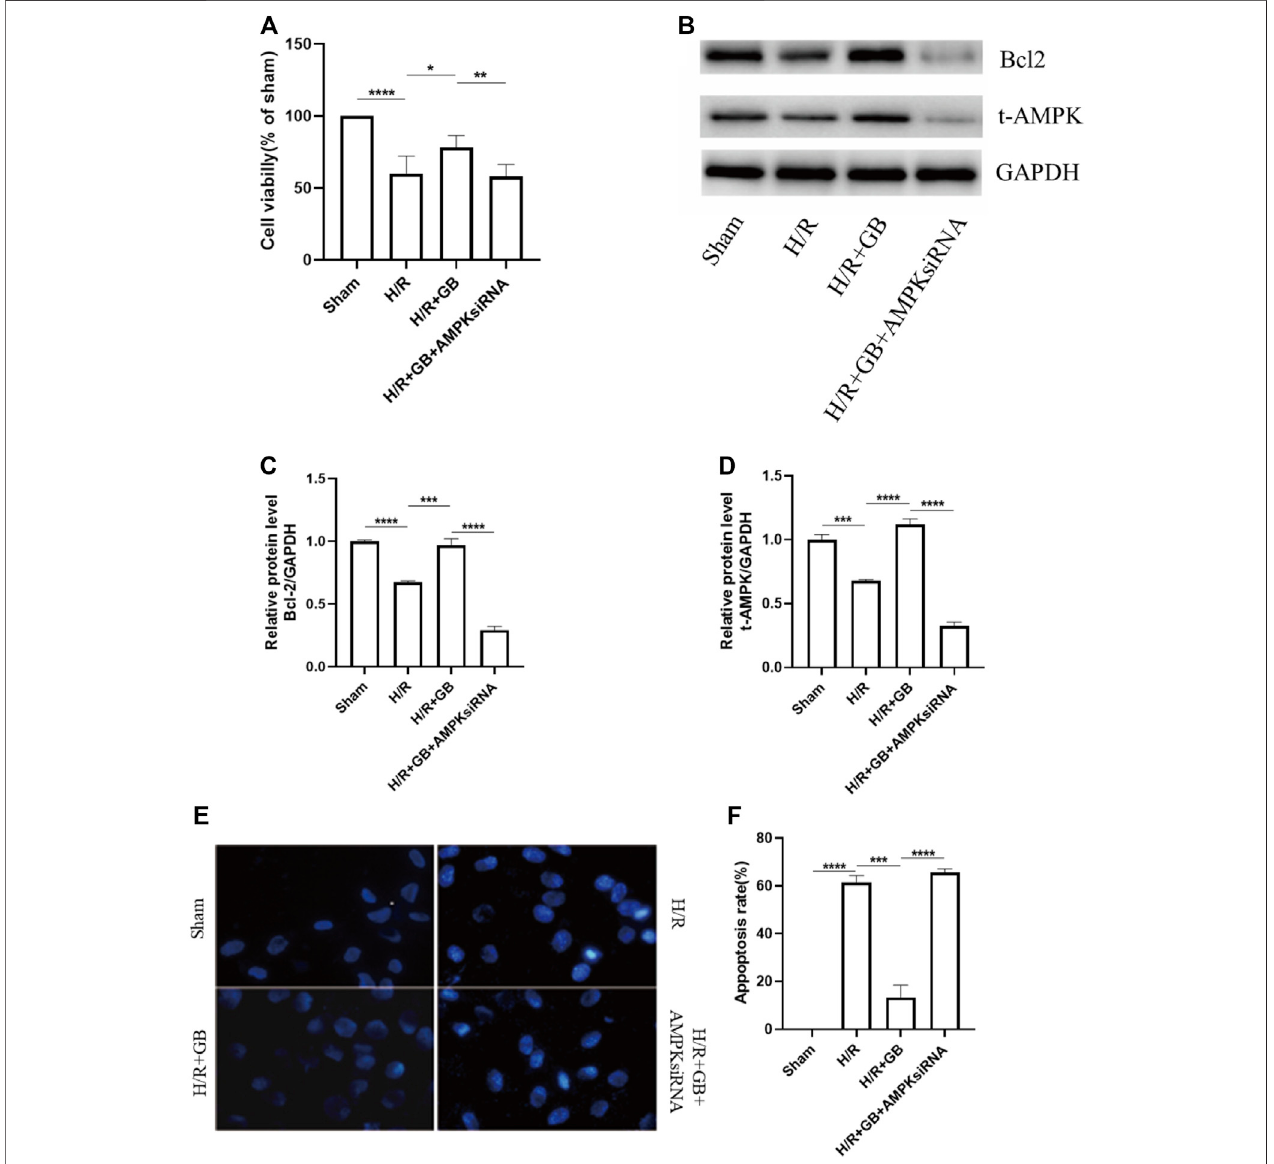
FIGURE 2 | (A) MTT assay was utilized to evaluate cell viability. Data are expressed as mean ± SEM and are representative of 3 separate experimentations. (B – D) Western blot images of Bcl-2, AMPK in SH-SY5Y cells subjected to H/R and treated with or without GB. (E,F) Hoechst 33342 staining representative images (E) . Bar graphs illustrating the apoptosis rate of the cells subjected to various treatments (F) . Data are expressed as mean ± SEM and represent 3 distinct experiments. (*** p < 0.001, **** p < 0.0001).